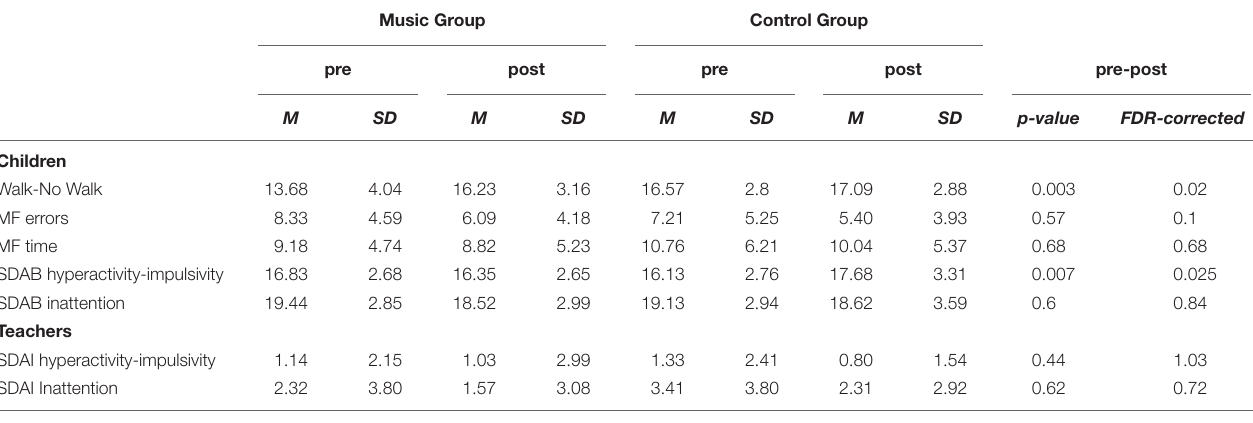
TABLE 2 | Means (M) and standard deviation (SD) of the scores obtained by the two groups (music group and control group) at pre-test and post-test and ANOVA results. Music Group